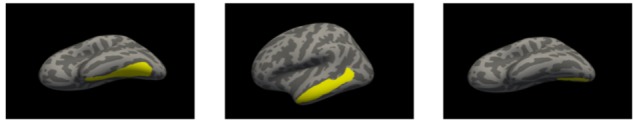
Fusiform gyrus, middle temporal ROI and posterior functional ROI.